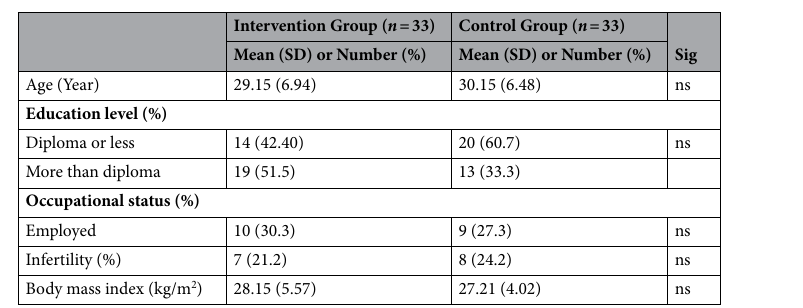
Figure 1. Consort diagram.